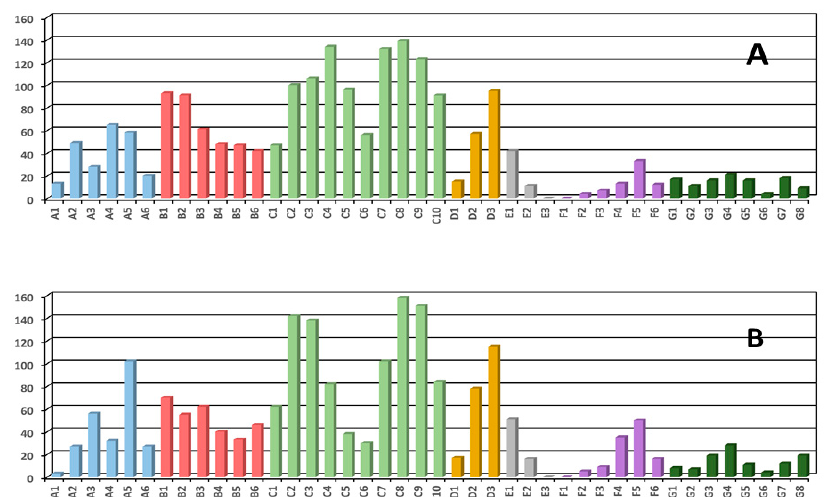
Figure 11. Number of anticyclonic eddies exported ( A ) and imported ( B ) by each 1° × 1° box.